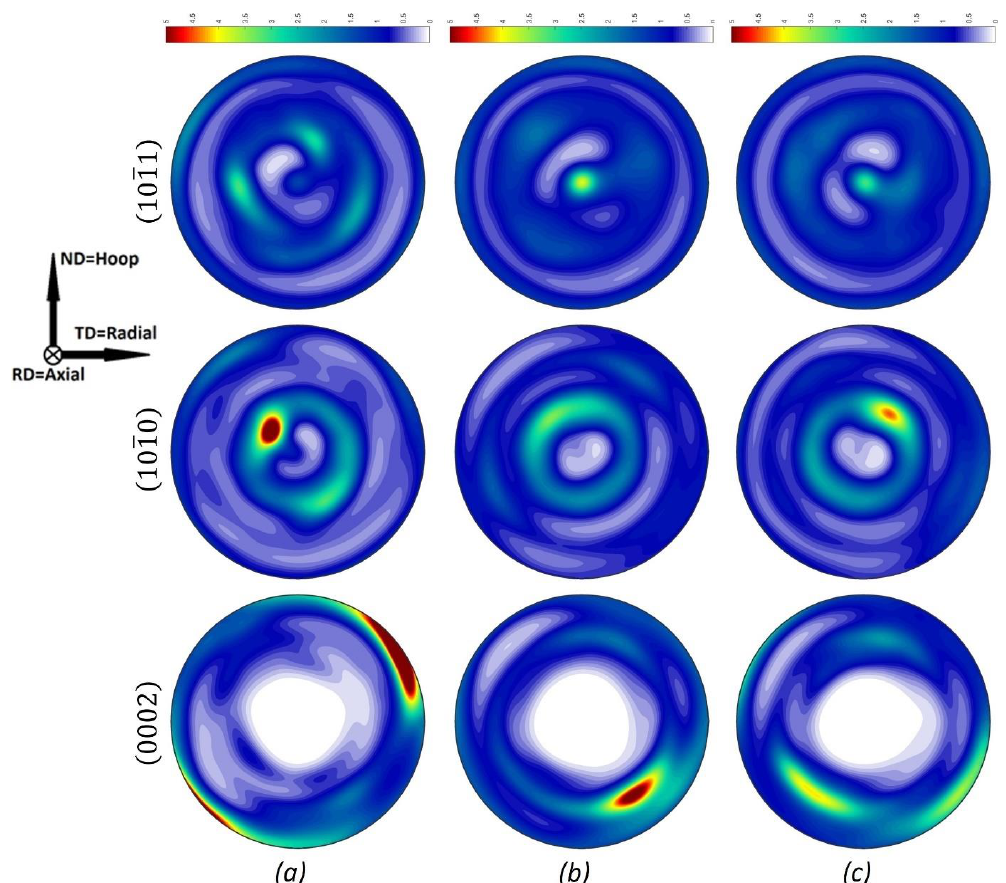
Figure 10. (0002) , (101̅0) , and (101̅1) pole figures after the third C-ECAP pass in the periphery ( a , c ) and in the central region ( b ) of the